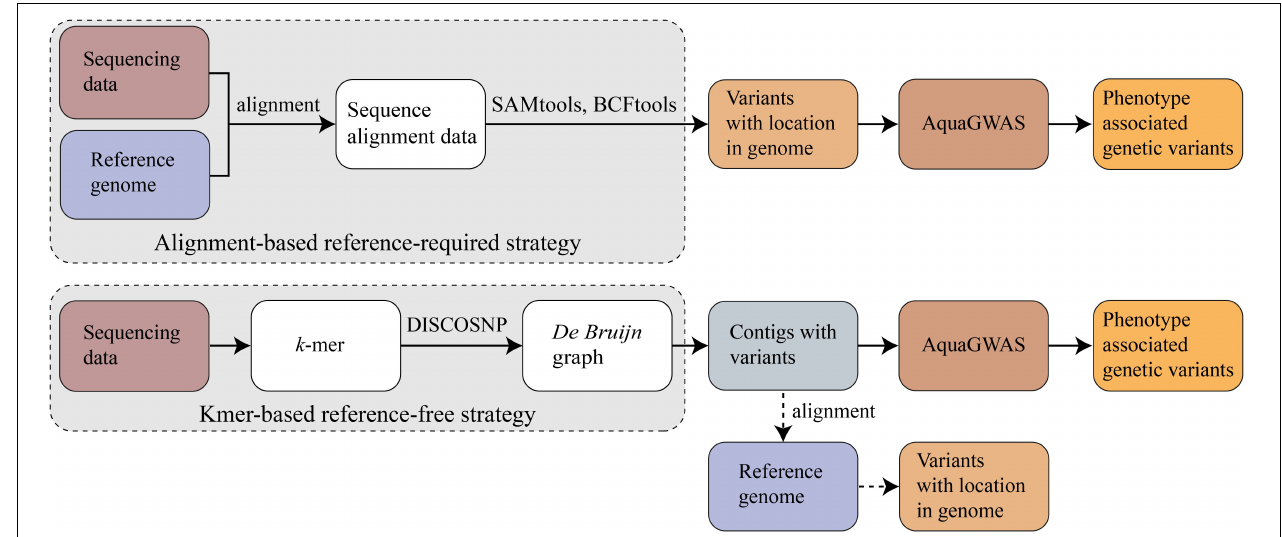
FIGURE 2 | The two different upstream strategies, namely, alignment-based reference-required and k -mer-based reference-free, combined AquaGWAS for genome-wide association study (GWAS). The alignment-based strategy aligns the genomic sequencing reads to reference genomic sequences and then calls the candidate genetic variants. Additionally, the k -mer-based strategy calls the candidate variants free from reference genomic sequence with a k -mer comparison based on a de Bruijn graph. The variants calling files from the above two strategies are input into AquaGWAS for GWAS.